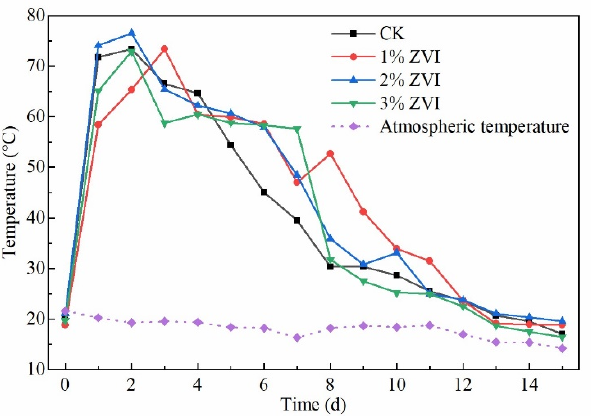
Figure 2. Changes in temperature of the composting pile with different ZVI additions. ZVI: zero- valent iron.